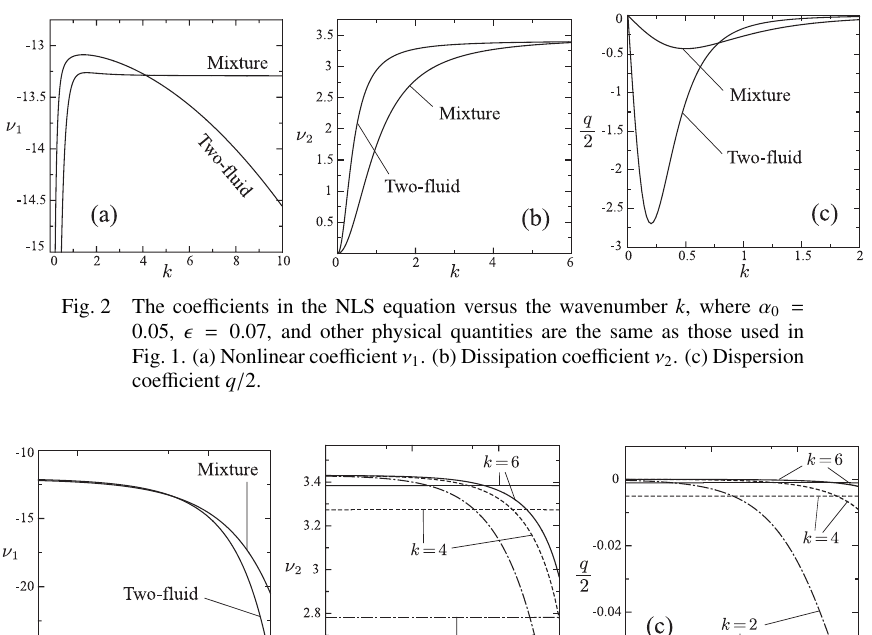
Fig. 3 The coe ffi cients in the NLS equation versus the initial void fraction α 0 , where k is fixed and other quantities are the same as those used in Fig. 2. In (b) and (c), k is chosen as three values, and curves and straight lines correspond to coe ffi cients derived from the two-fluid model and mixture model, respectively. (a) ν 1 . (b) ν / 2 . (c) q